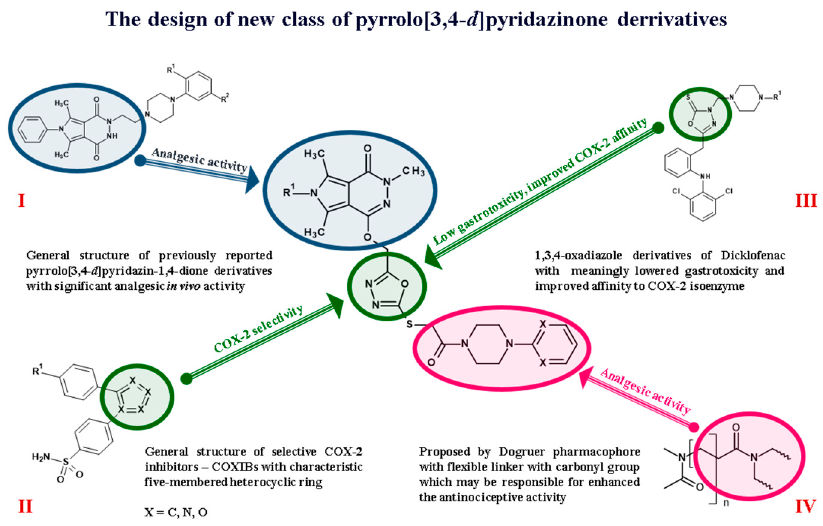
Figure 2. The outline of the concept of the uprising of novel pyrrolo[3,4- d ]pyridazinone derivatives.